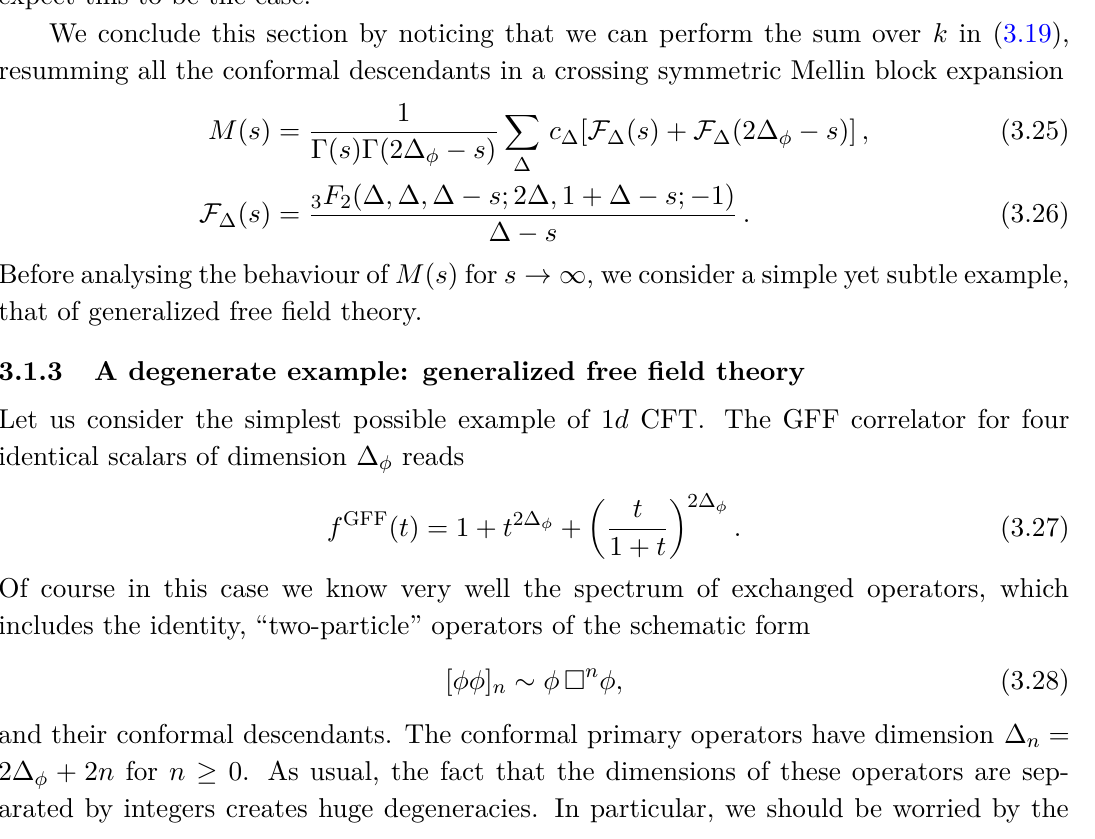
∆ left and right poles intersect and the contour 0 < φ